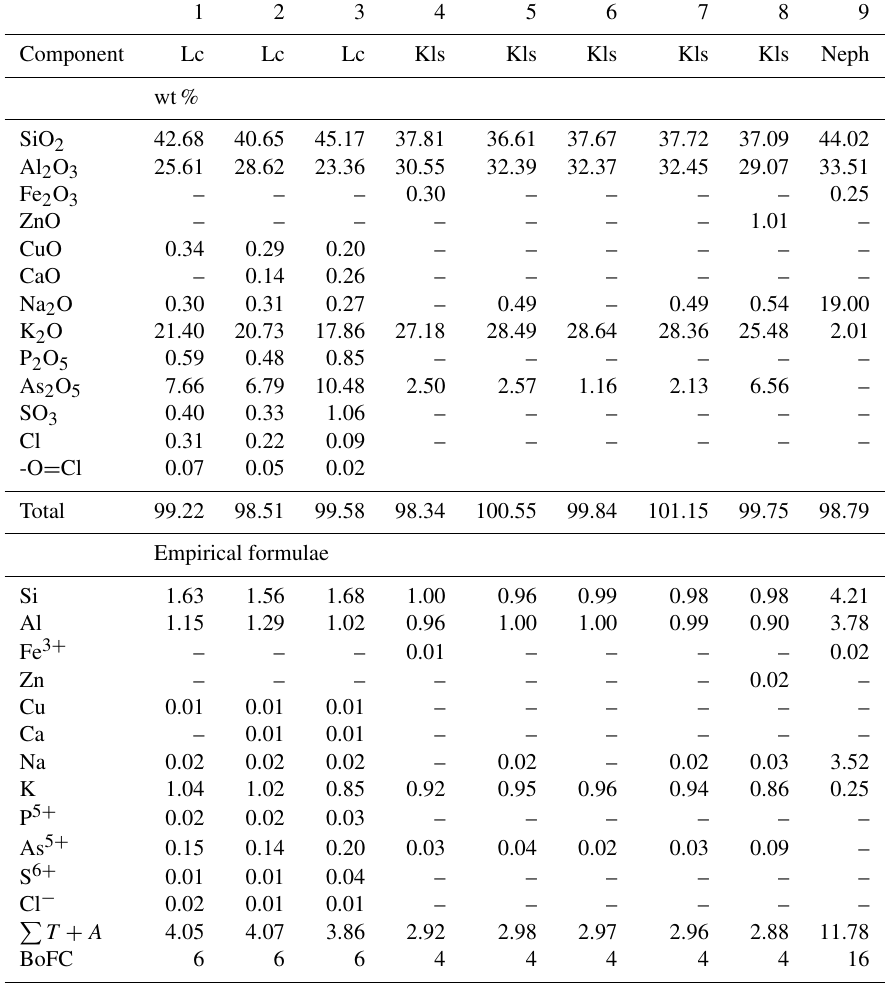
Table 4. Chemical composition of leucite (Lc), kalsilite (Kls) and nepheline (Neph) from the Arsenatnaya fumarole. 1 2